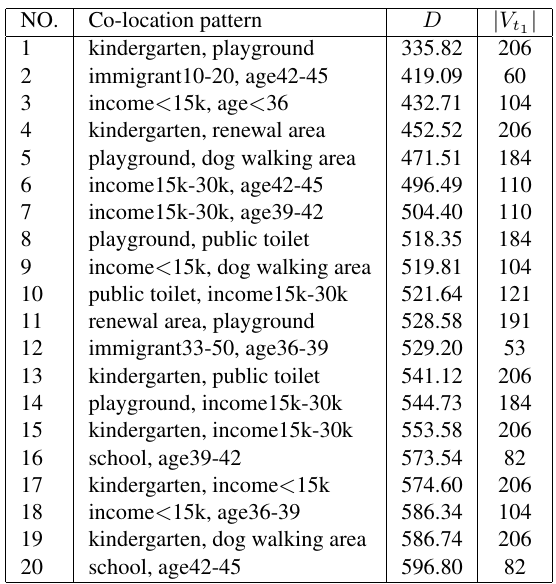
Table 2. Co-location patterns found by CoDis